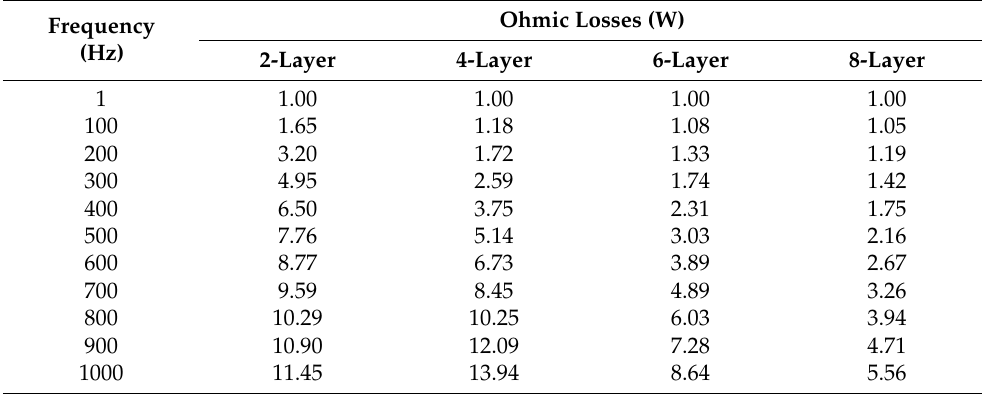
Table 4. AC losses factor of various layer layouts.